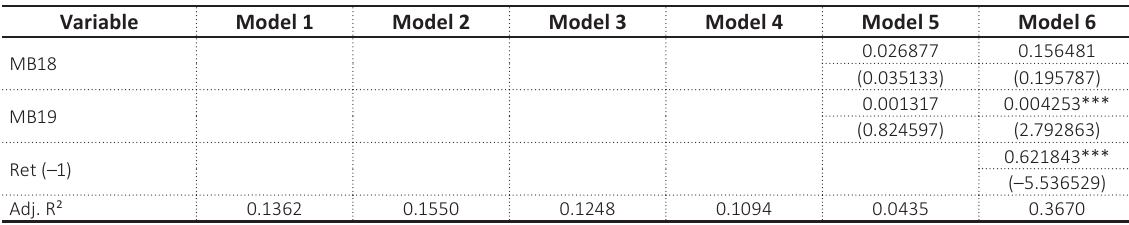
Table 4 (cont.). Estimates from the baseline models